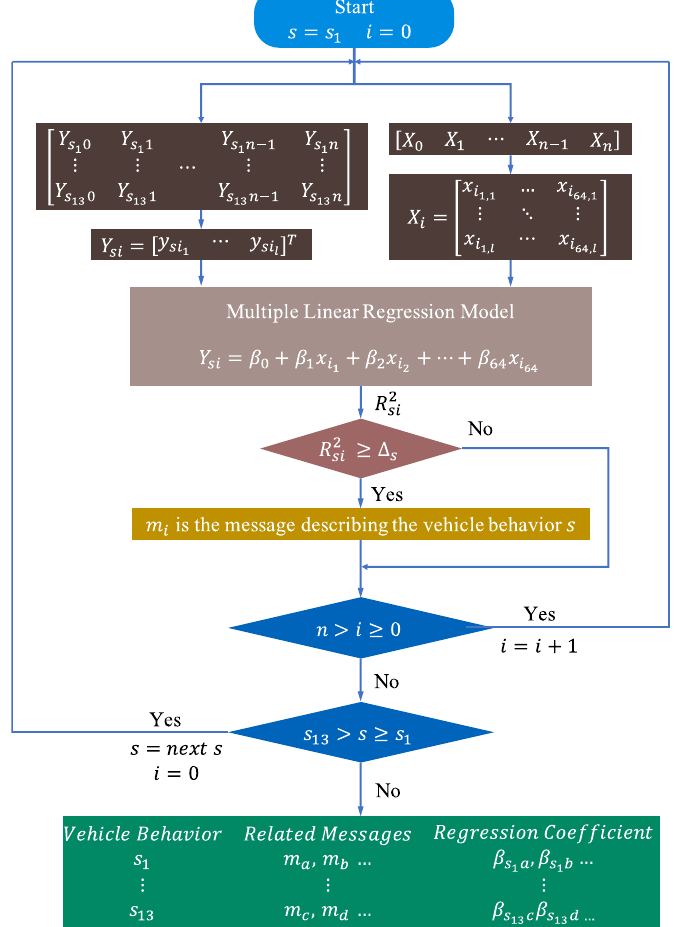
Figure 7. Message selection based on 𝛽 .